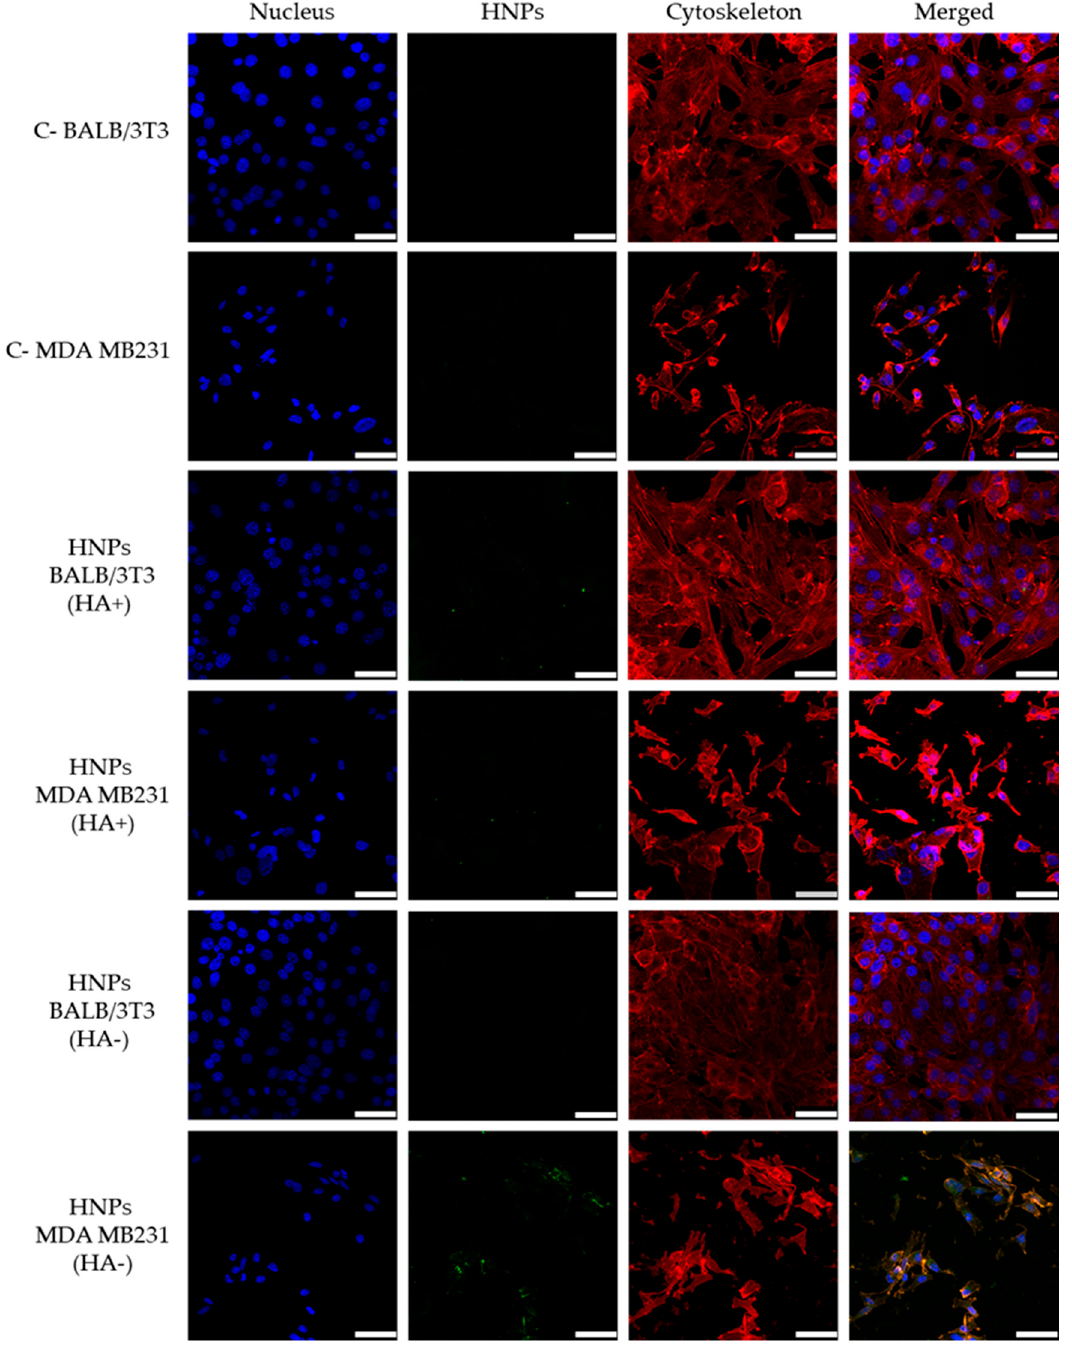
Figure 8. Representative confocal images of MDA-MB231 and BALB/3T3 cells exposed to HNPs (0.1 mg mL − 1 ) for 24 h. CD44 receptors were blocked with free hyaluronic acid (HA) (10 equivalents of HNPs concentration) 1 h before treatment with HNPs. Green, blue, and red fluorescence correspond to fluorescein isothiocyanate (FITC)-HNPs, cell nuclei and cytoskeleton, respectively. Cells exposed to culture medium were used as the negative control. Scale bar: 50 μ m.